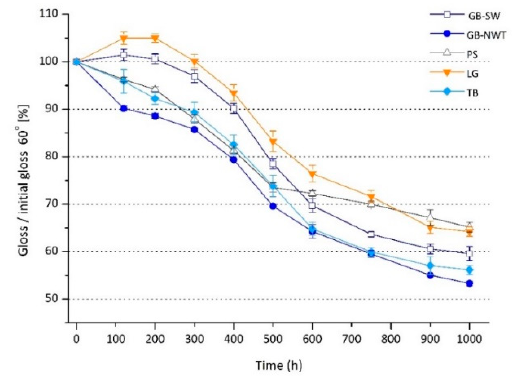
Figure 3. Sample residual gloss after irradiation with UVB light.